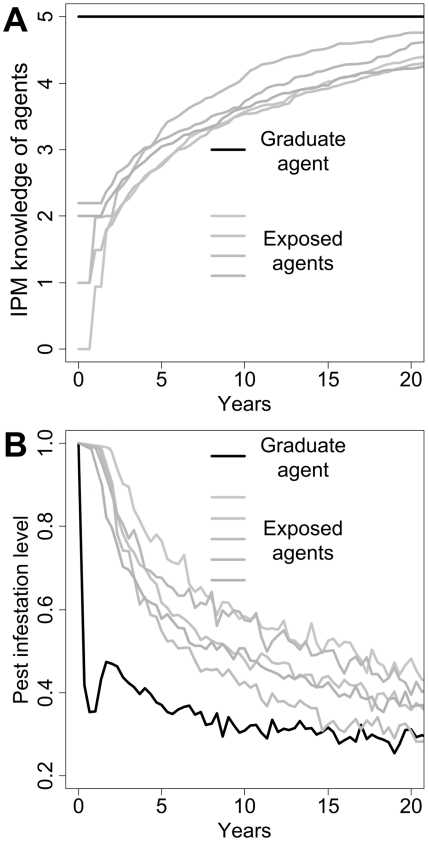
Results of ABM simulations.ABM results showing the evolution of IPM knowledge of agents (A) and pest infestation level (B) through time (mean of 100 simulations).